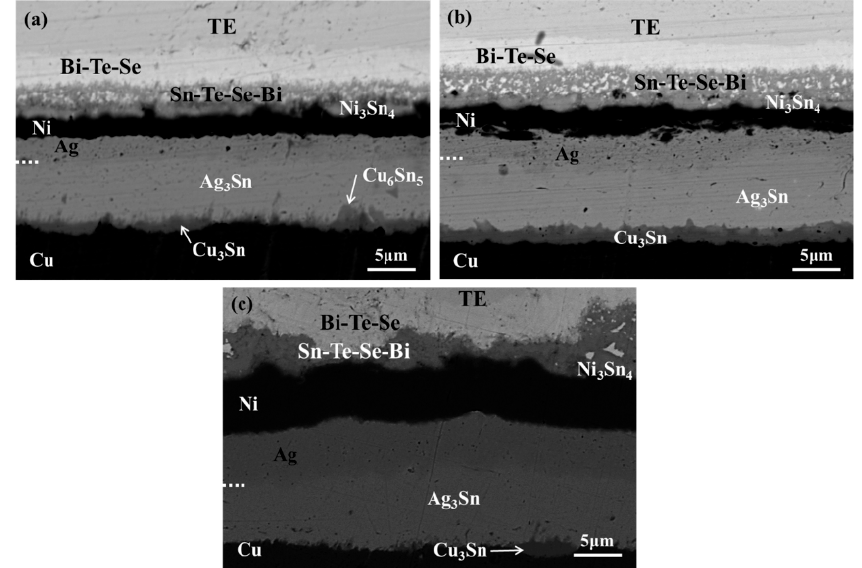
Figure 3. Morphology of intermetallic compounds formed after diffusion soldering between Bi 2 Te 2.55 Se 0.45 thermoelectric material and the Cu electrode with Sn interlayers at 250 °C for various times: ( a ) 5 min, ( b ) 10 min, ( c ) 30 min.